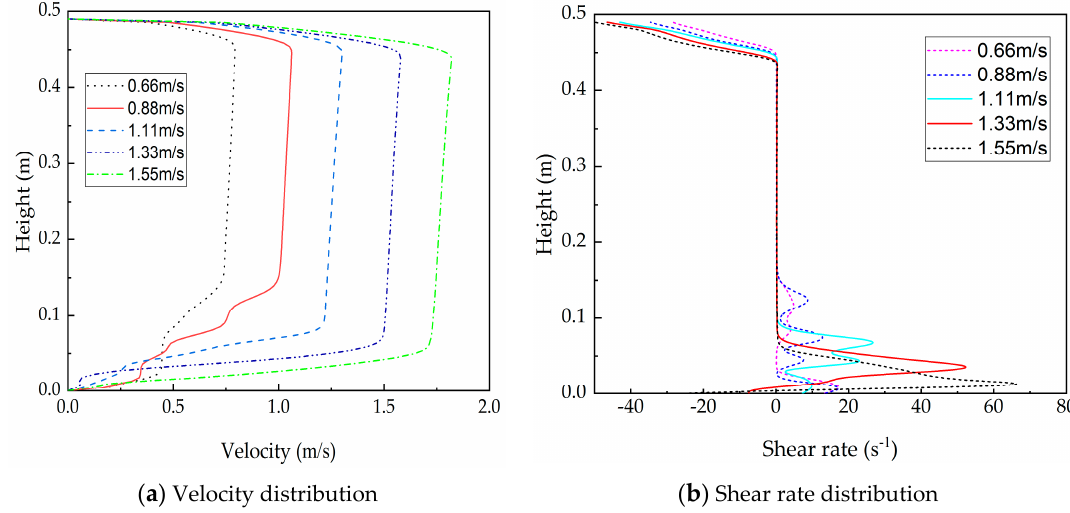
Figure 16. Velocity distribution and shear rate distribution of the A-A section ( α = 20°).